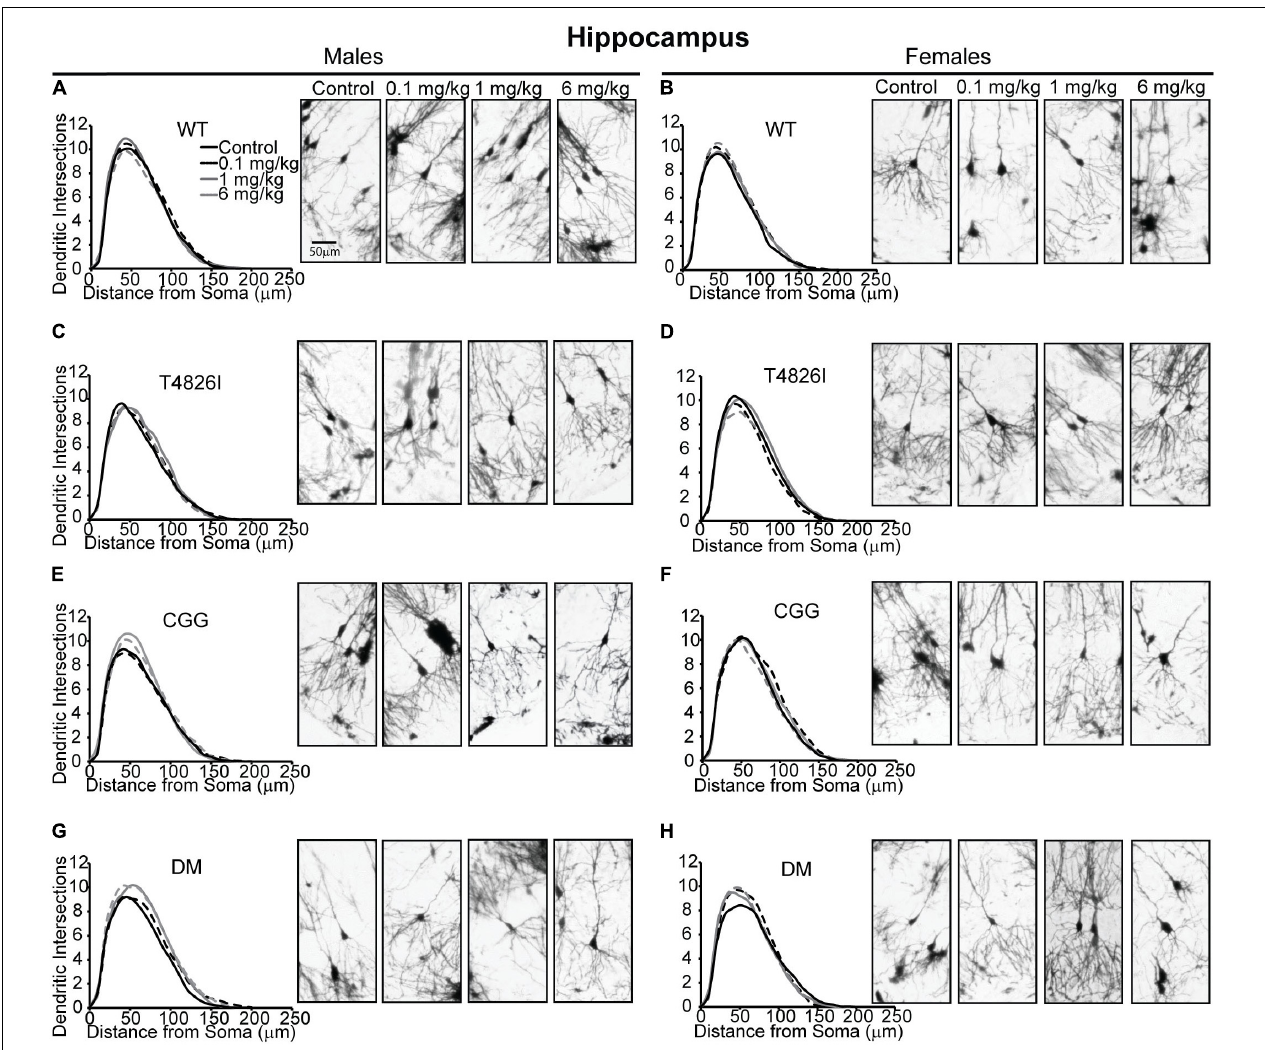
FIGURE 1 | Genotype influences the effect of PCBs on the dendritic morphology of pyramidal neurons in the CA1 hippocampus of juvenile mice. Sholl plots and representative images of the basilar dendritic arbors of Golgi-stained pyramidal CA1 hippocampal neurons derived from P27–31 male and female (A,B) WT, (C,D) T4826I, (E,F) CGG, or (G,H) DM mice exposed to the MARBLES PCB mixture in the maternal diet throughout gestation and lactation. N = 39–49 neurons from at least six independent mice per sex per genotype per dose. Also see Supplementary Figure 1 for representative tracings of the basilar dendritic arbors of Golgi-stained pyramidal hippocampal